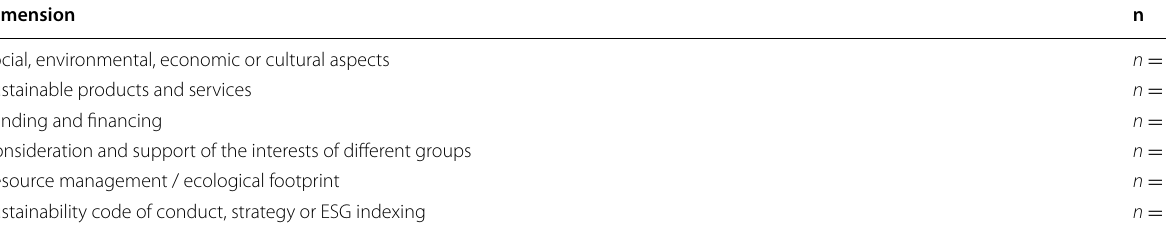
Table 9 Consolidated result of the definition analysis on dimensions of sustainable banking